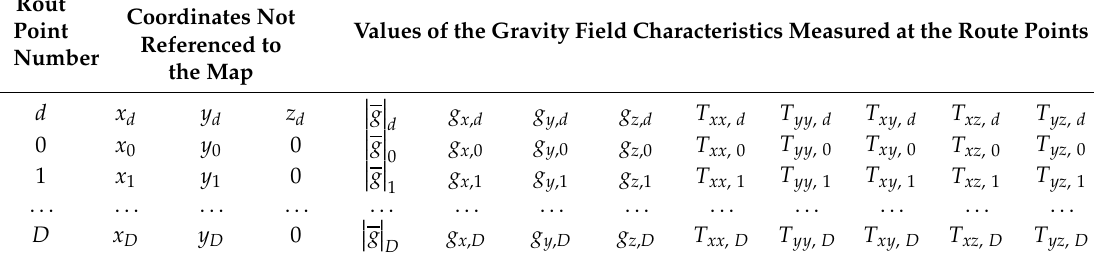
Table 6. Matrix of the non-referenced